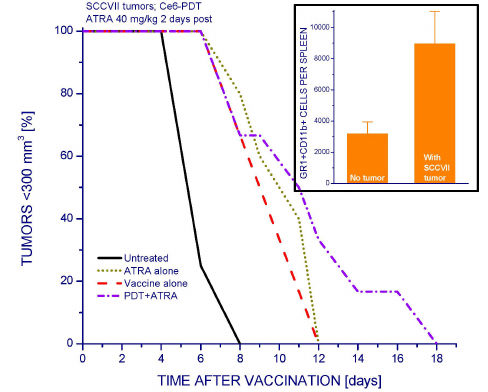
Figure 6. The impact of single ATRA treatment on the efficacy of PDT vaccine. Mice with SCCVII tumors were treated with PDT vaccine as described for Figure 1. The injection of ATRA (40 mg/kg i.p.) was given two days after vaccination. The results are presented as percentages of mice with tumors smaller than 300 mm 3 in function of time after vaccination. Each treatment group consisted of six mice. Statistically significant ( p < 0.05) were the differences between the control untreated group response and all three treatment groups responses, as well as between vaccine alone and vaccine plus ATRA groups responses. The numbers of MDSCs (GR1 + CD11b + cells) per spleen in mice with and without SCCVII tumors are shown in the insert. The difference between the two groups in the insert was statistically significant ( p < 0.05).